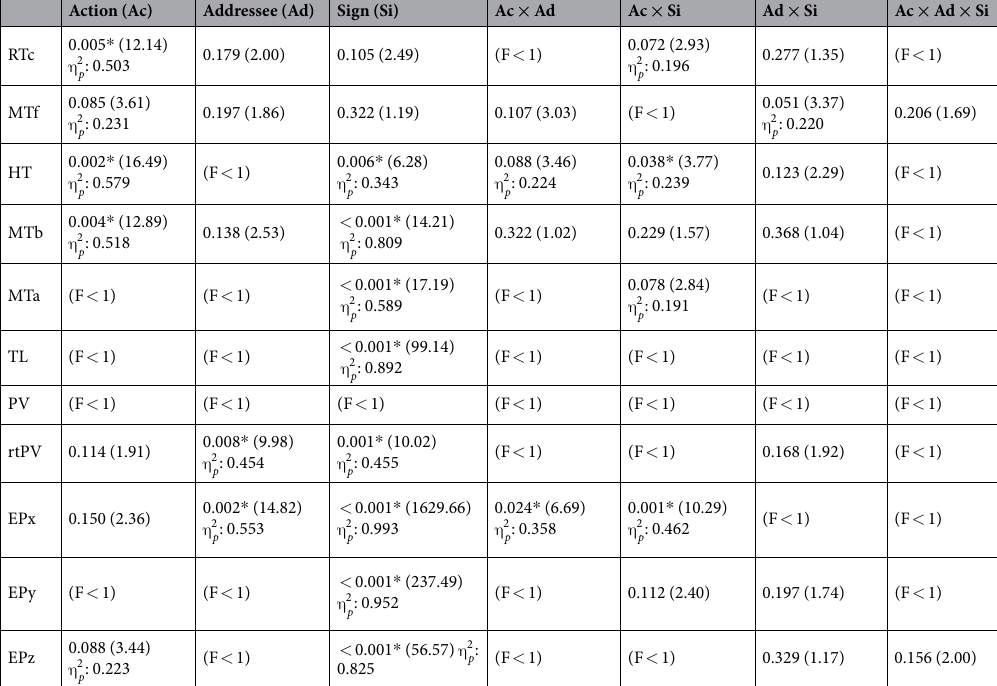
Table 2. Statistics: the p-value, F-value and effect size of the observed results. Statistics are obtained from a univariate repeated-measures ANOVA with 1 degree of freedom (or 2 whenever sign is included as a factor) for the test and 12 degrees of freedom (or 24) for the error. F-values are reported between brackets. Only effects with an F-value larger than 1 are reported in full. Partial eta-squared is reported only for (marginally) significant effects. Significant effects ( p < 0.05) are marked by * . All abbreviations and conventions as in Table